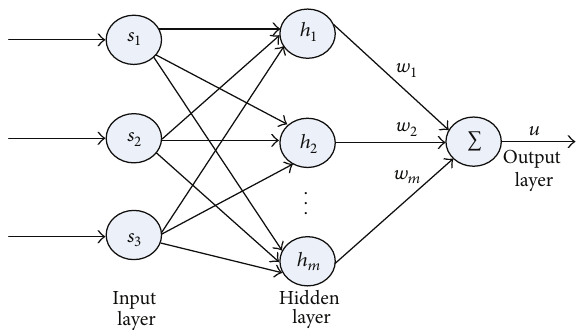
Figure 3: Structure of RBF neural